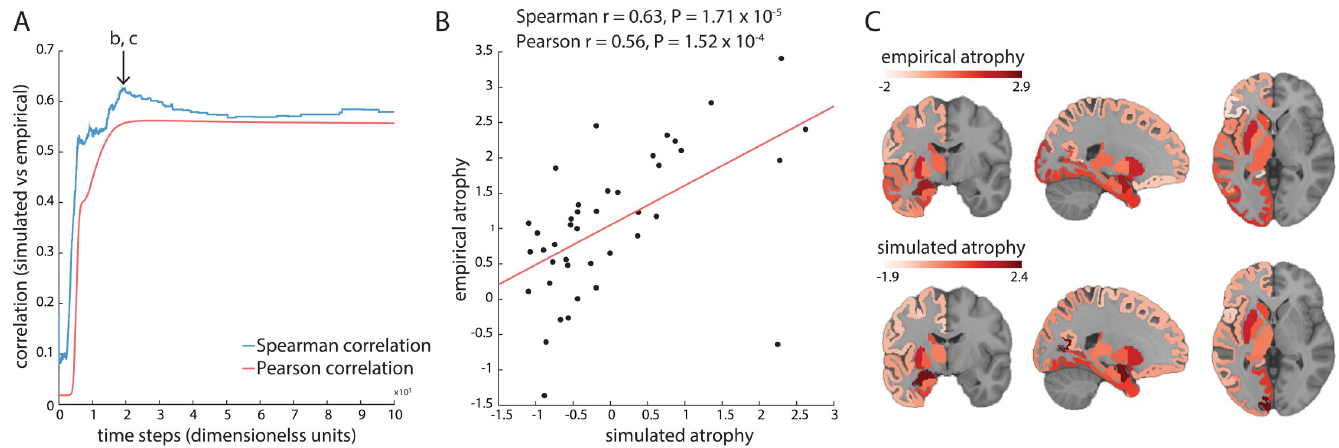
Fig 2. Model fit. (A) Correlations between simulated atrophy and empirical atrophy derived from PD patient DBM maps up to t = 10 4 . Correlations are shown as a function of simulation time. After reaching the peak value ( r = 0.63, p = 1.71 × 10 − 5 ), the model fit slightly drops and finally stabilizes. See S2 Fig for correlations up to t = 10 5 . (B) Model fit at the peak of Spearman’s correlation taken from panel A. Using Pearson’s correlation coefficients yielded comparable results ( r = 0.56, p = 1.52 × 10 − 4 . Values shown in the axes are normalized. The outlier at the bottom right is the nucleus accumbens (for a possible explanation see Discussion). (C) Simulated atrophy and empirical atrophy plotted on the MNI152 standard template. The slices were chosen at x = − 22, y = − 7, z = 0 (MNI coordinates). The underlying data can be found at https://github.com/yingqiuz/SIR_simulator/blob/master/results/Fig2.mat. DBM, Deformation-Based Morphometry; MNI, Montreal Neurological Institute; PD, Parkinson disease.